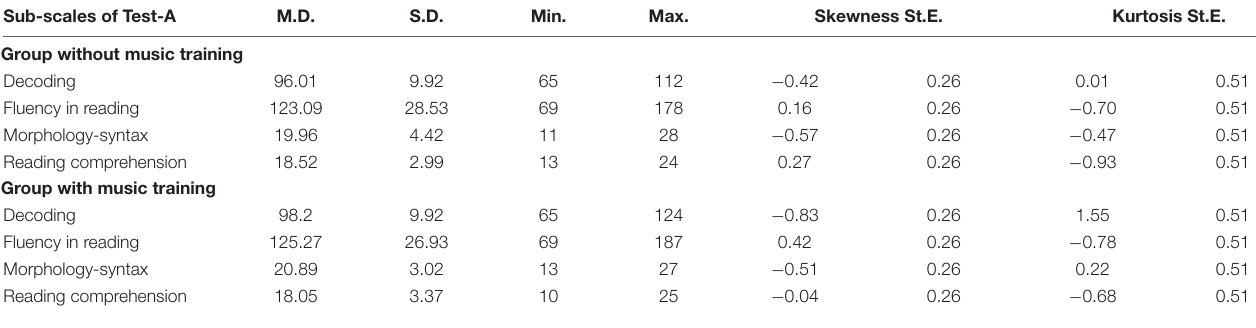
TABLE 1 | Mean and standard deviations, maximum and minimum, and values for skewness and kurtosis for measuring the reading comprehension of the two groups. Sub-scales of